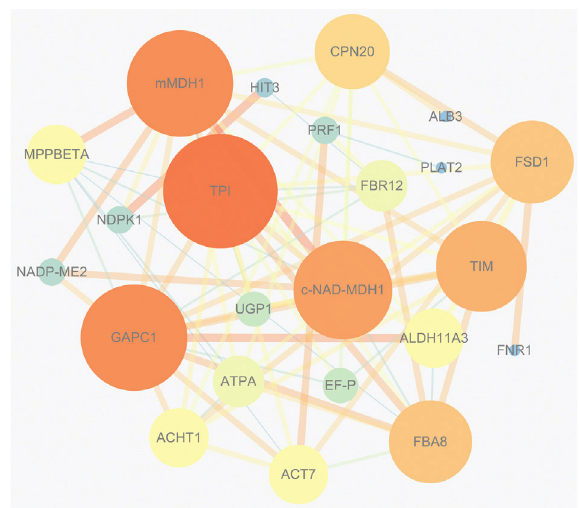
Figure 4 - Schematic representation of the protein-protein interaction net- work of the differentlial proteins in the Bnclv-like . Proteins with larger numbers of interacting proteins are represented by a larger circle size and color depth. The line width represents the reliability of the predicted inter- action between two proteins, where interactions containing more evidence are thicker. The network was initially constructed from Bnclv-like differ- ential proteins using the STRING database and reconstructed by Cytos-